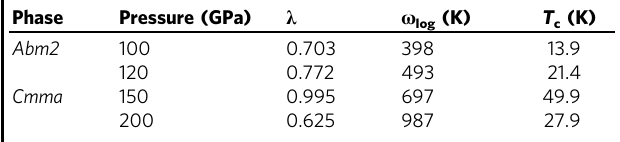
Table 1 Calculated EPC parameter ( λ ), logarithmic average phonon frequency ( ω log ) and superconducting temperature (T c ) for stable phases of AMS at the pressures